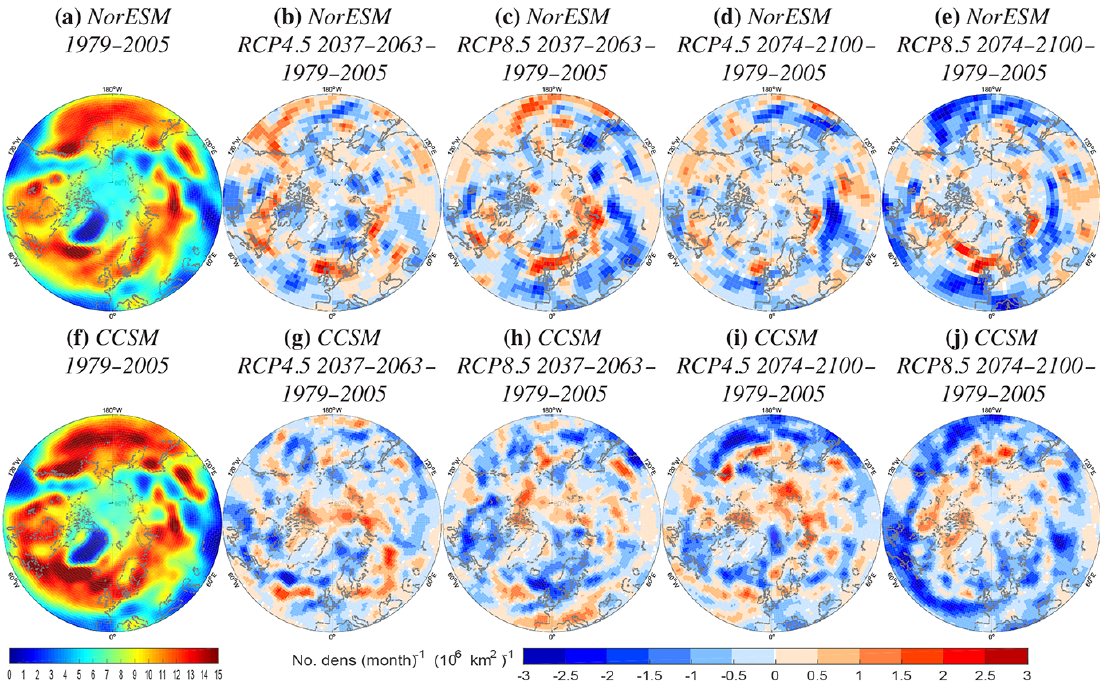
Figure 3. Track density (a, f) averages for SOND 1979–2005 and (b–e, g–j) changes in average over various time periods and scenarios com- pared to 1979–2005 in NorESM (upper row) and CCSM (lower row). The time periods and scenarios are (b, g) RCP4.5 2037–2063 − 1979–